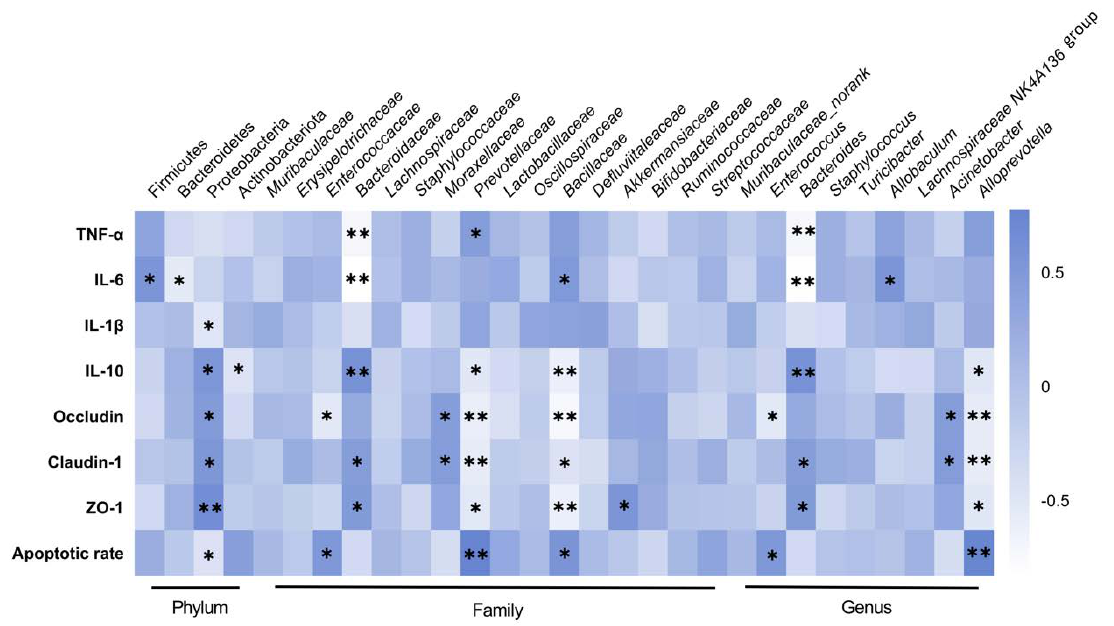
Figure 5. Correlation analysis heatmap (only significant correlations (* p < 0.05, ** p < 0.01) are